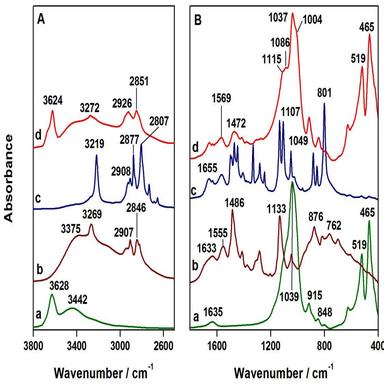
MIR spectra of a) Na-Mt, b) neat PEI measured in unheated KBr pellet, c) neat PEI measured in heated KBr pellet, and d) PEI 430-Mt, measured in heated KBr pellet. A- 3800–3500 region, B-1700–400 cm− 1 region.